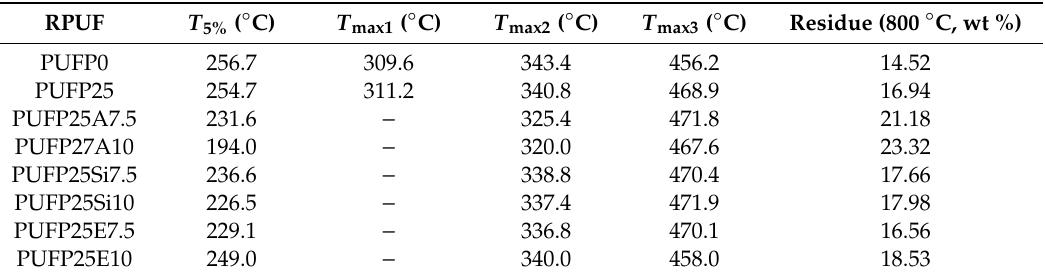
Figure 10. The TG ( a, c ) and DTG ( b, d ) curves of RPUF. Table 3. TG data of RPUF a .